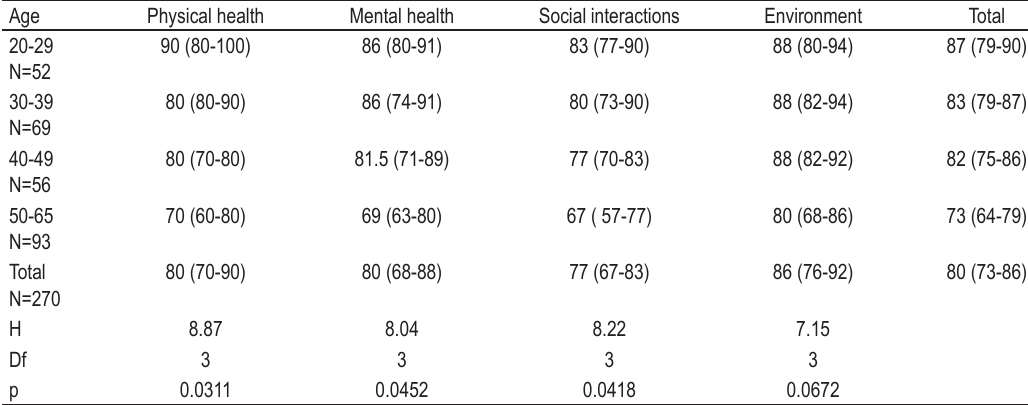
TABLE 2. Subjective perception of quality of live according to the age of